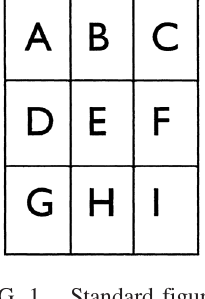
FIG. 1. Standard figure.